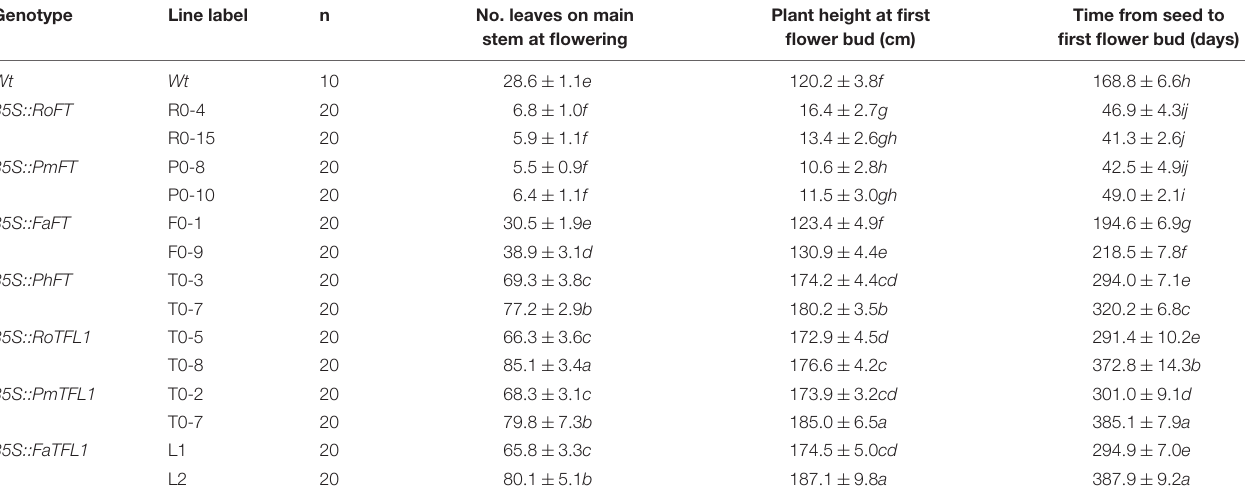
TABLE 1 | Flowering phenotypes of representative T 1 transgenic tobacco lines harboring various FT/TFL 1 homologs.